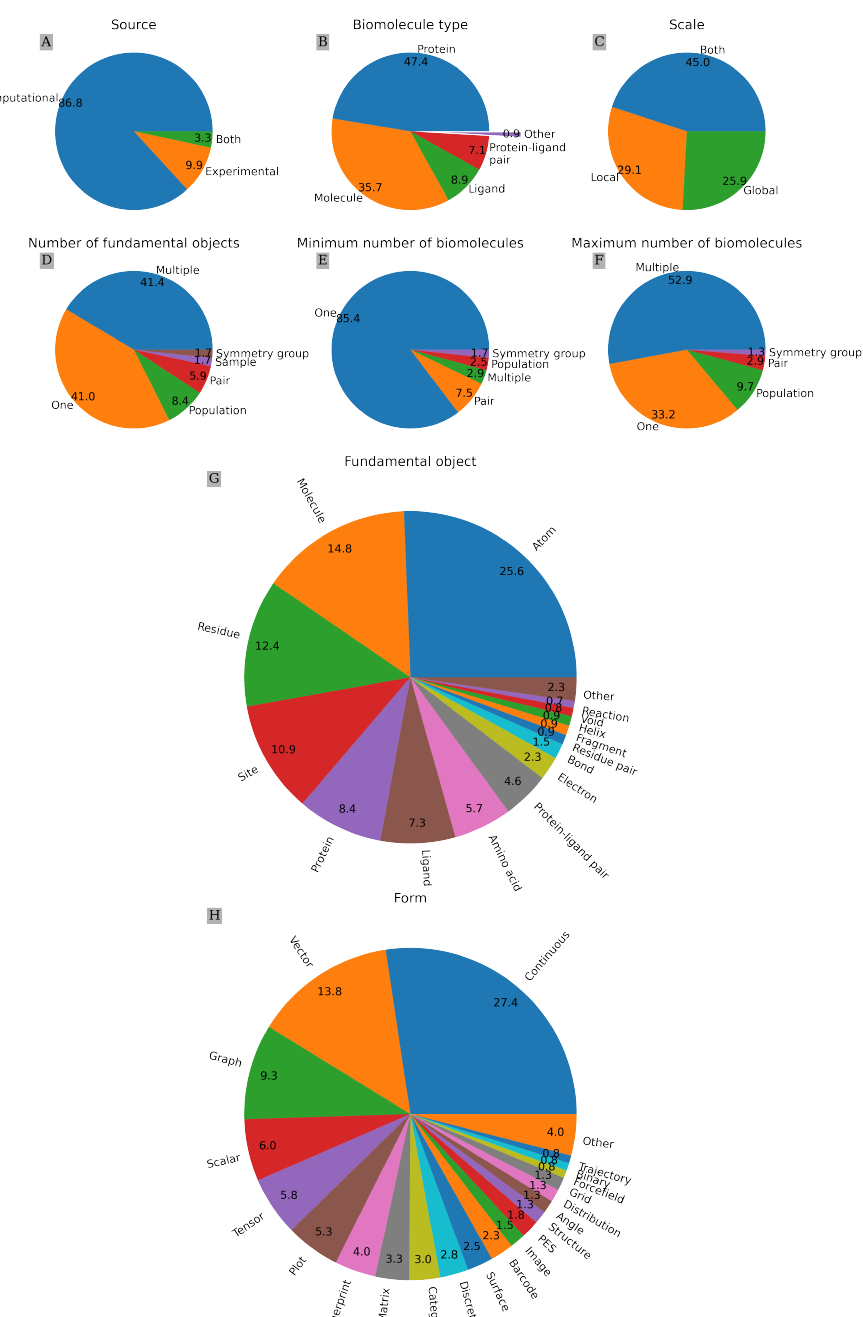
Figure 7. Frequency of mutually exclusive properties across a sample of surveyed features: ( A ) source, ( B ) biomolecule type, ( C ) scale, ( D ) number of objects, ( E ) minimum number of biomolecules, ( F ) maximum number of biomolecules, ( G ) fundamental object frequency, and ( H ) form frequency. Continuous features constitute a plurality of surveyed features, which makes intuitive sense as structural features are well represented. Furthermore, 50.5% of features